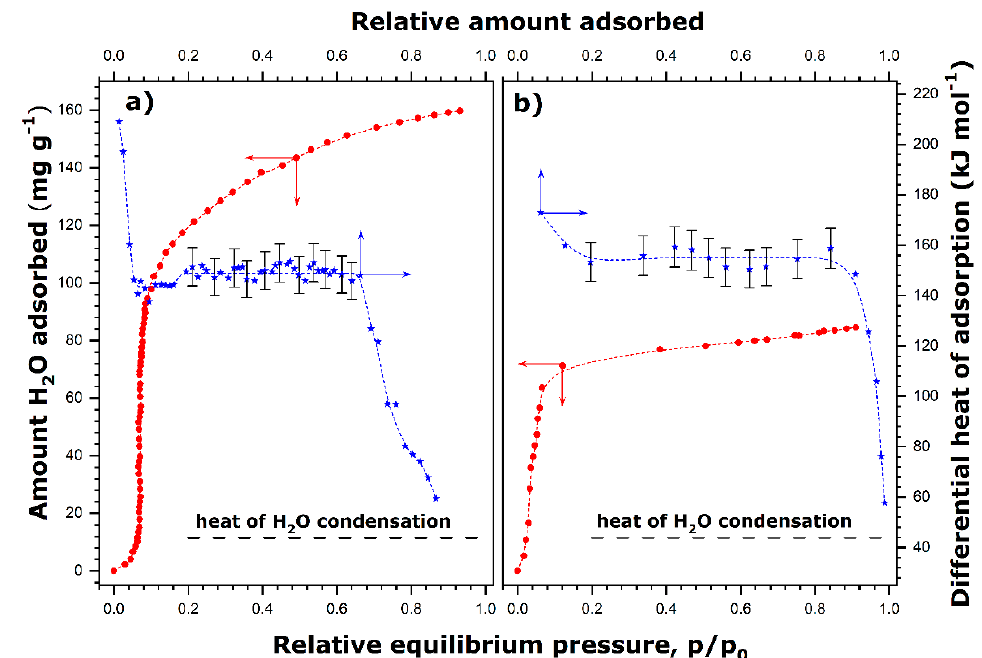
Figure 1. Adsorption isotherms and differential heat of adsorption curves for PBA on which the adsorption of water vapor was carried out at 298 K after the degassing treatment at 423 K ( a ) and 353 K ( b ). The quantity of adsorption (red circles) is plotted against the relative equilibrium pressure, p/p 0 , where p 0 is the saturated vapor pressure. The differential molar heat of adsorption (blue stars) is represented as a function of the relative amount adsorbed, calculated as a ratio between a given quantity of adsorption and its value at p/p 0 = 0.8. The dashed lines are a guide for the eye (the error bars were added for some of the heat values, which are suggested lying on an intermediate heat plateau).